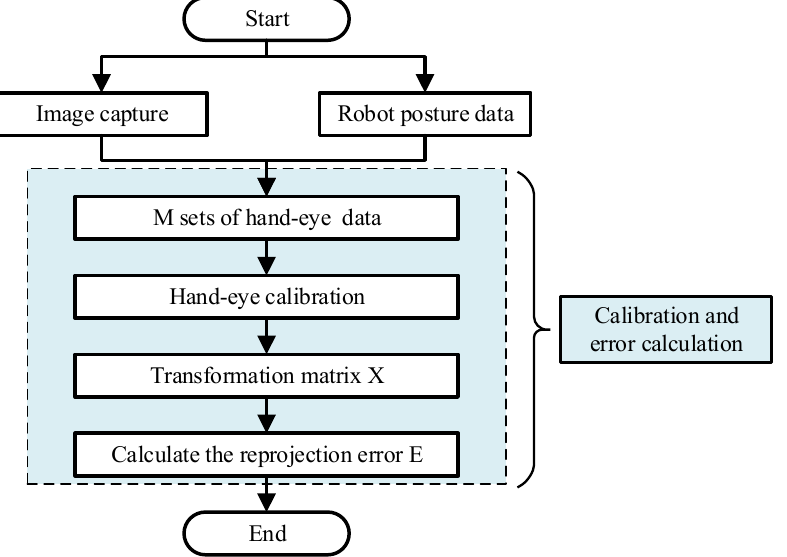
Figure 3. Hand–eye calibration process. During hand–eye calibration, M sets of A i ( i = 1, 2, …, M) B and its response to i ( i = 1, 2, …, M) is used to solve for